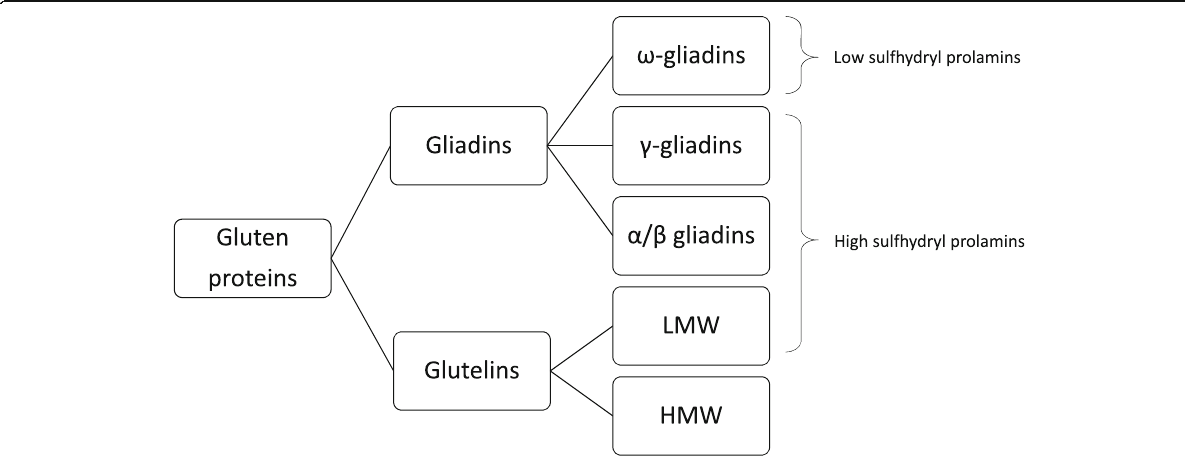
Fig. 3 Classification of gluten proteins by type of protein and content of sulfhydryl groups. (adapted from Shewry and Tatham